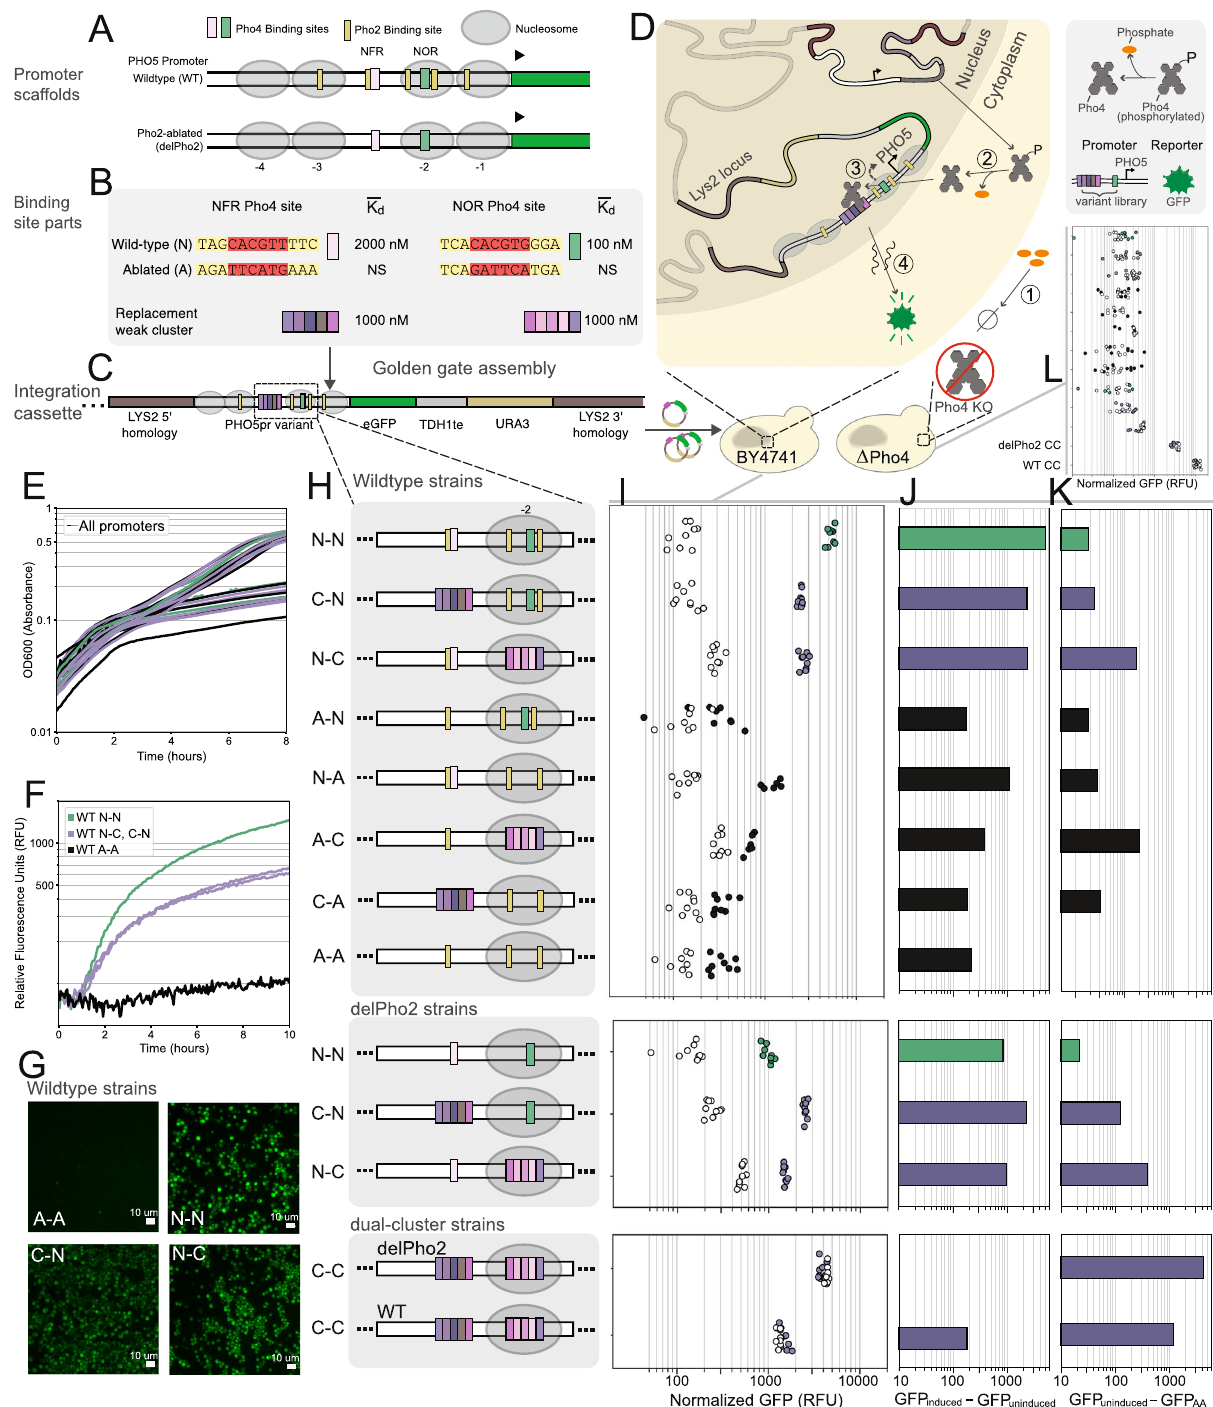
Fig. 7 | In vivo characterization in a native gene regulatory system. A PHO5 promoterscaffoldsinwhichnativePho4bindingsitesarereplacedwithlow-af fi nity Pho4 clusters. B Legend of Pho4 binding site parts. Native binding regions con- taining Pho4 and Pho2 sites either have their Pho4 binding sites ablated, or are replaced with clusters of low-af fi nity Pho4 binding sites. C Promoters were assembledintoamulti-cassetteplasmidandintegratedintotheLYS2locusofeither BY4741 or Pho4 knockout ( Δ Pho4) yeast strains. D Schematic of the response (induction) to phosphate starvation. E OD600 time series measurements for the full BY4741 library of promoters, both for uninduced and induced conditions. F Induction time series measurements for select cluster-containing